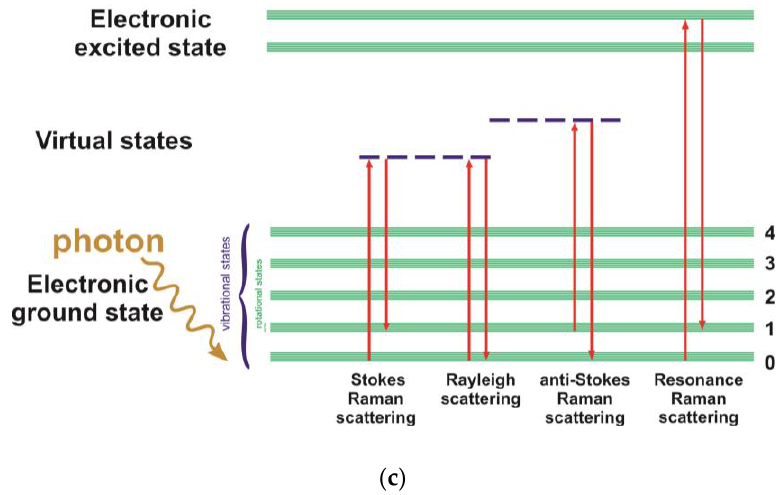
Figure 2. Energy transitions typical for the measurements by infrared and Raman spectroscopy are: ( a ) IR absorption (energy transitions corresponding to the overtone or fundamental transition are shown for near-IR and mid-IR spectroscopy, respectively); ( b ) photoluminescence, which often occurs during the study of biological objects by Raman spectroscopy; and ( c ) various Raman radiation types. Adapted from [29].